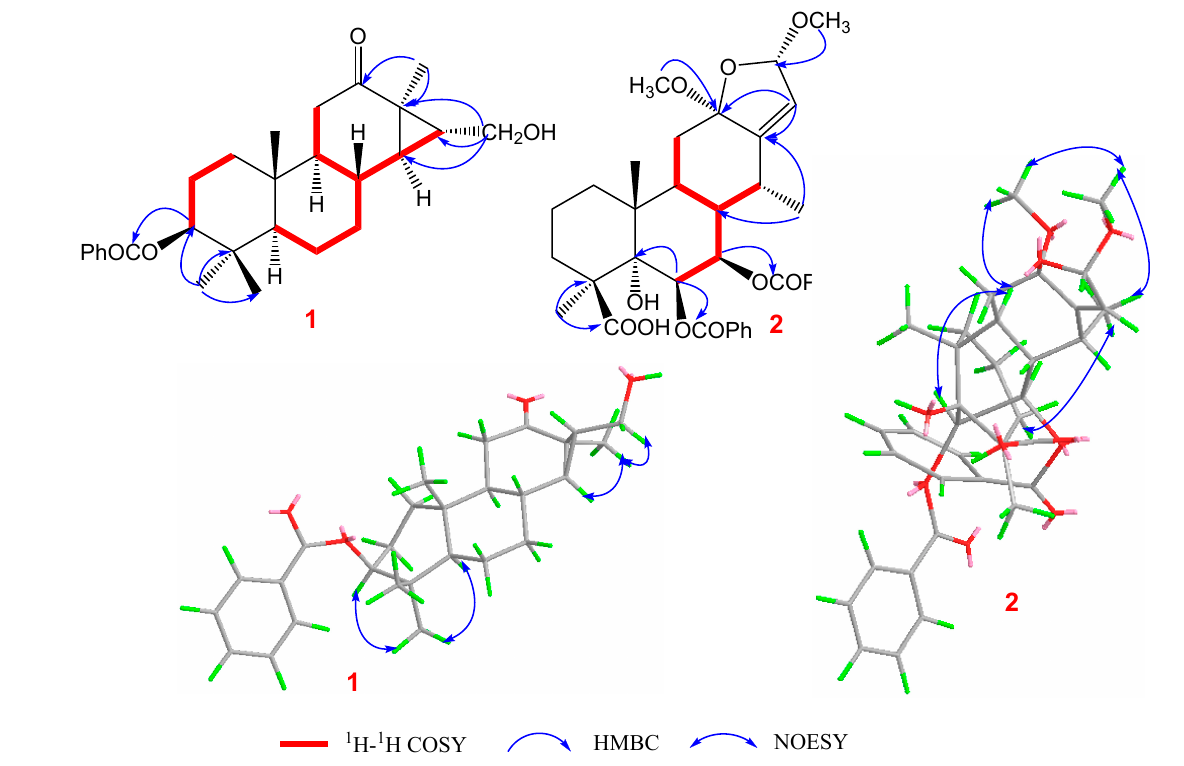
Figure 1. Key 1 H- 1 H COSY, HMBC, and NOESY correlations of compounds 1 and 2 .